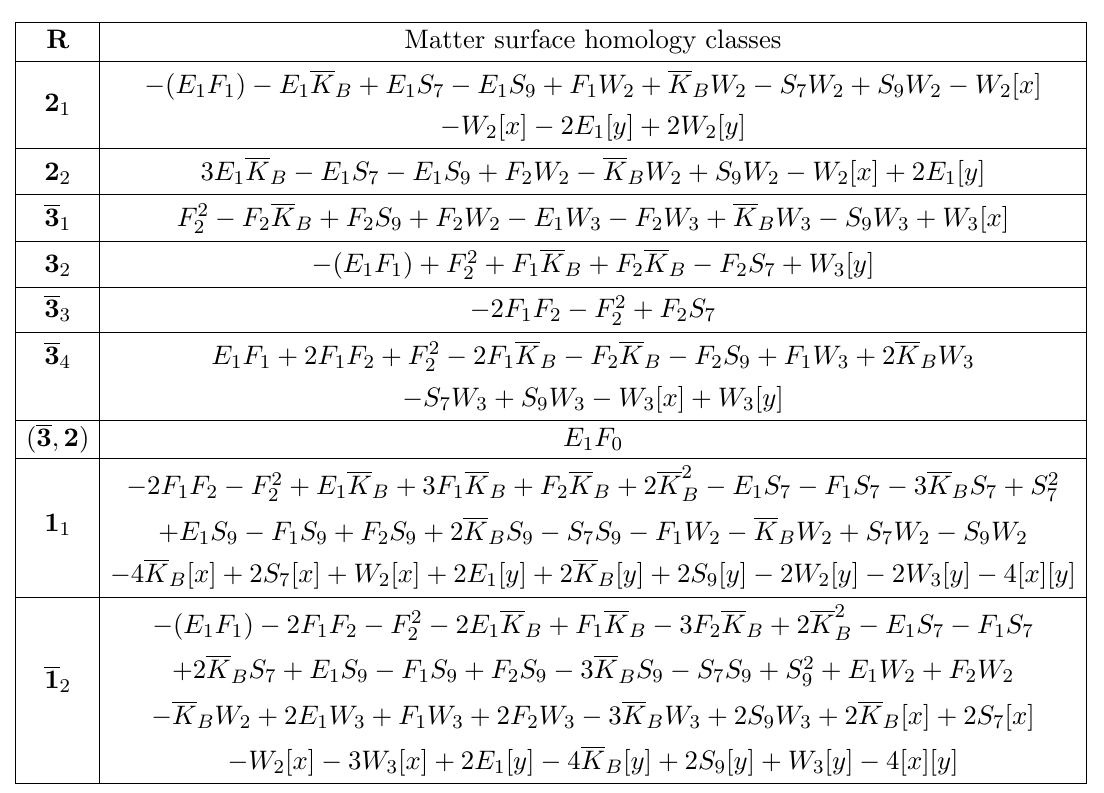
Table 8 . Summary of matter homology classes restricted to CY of (cid:12)rst top combination.